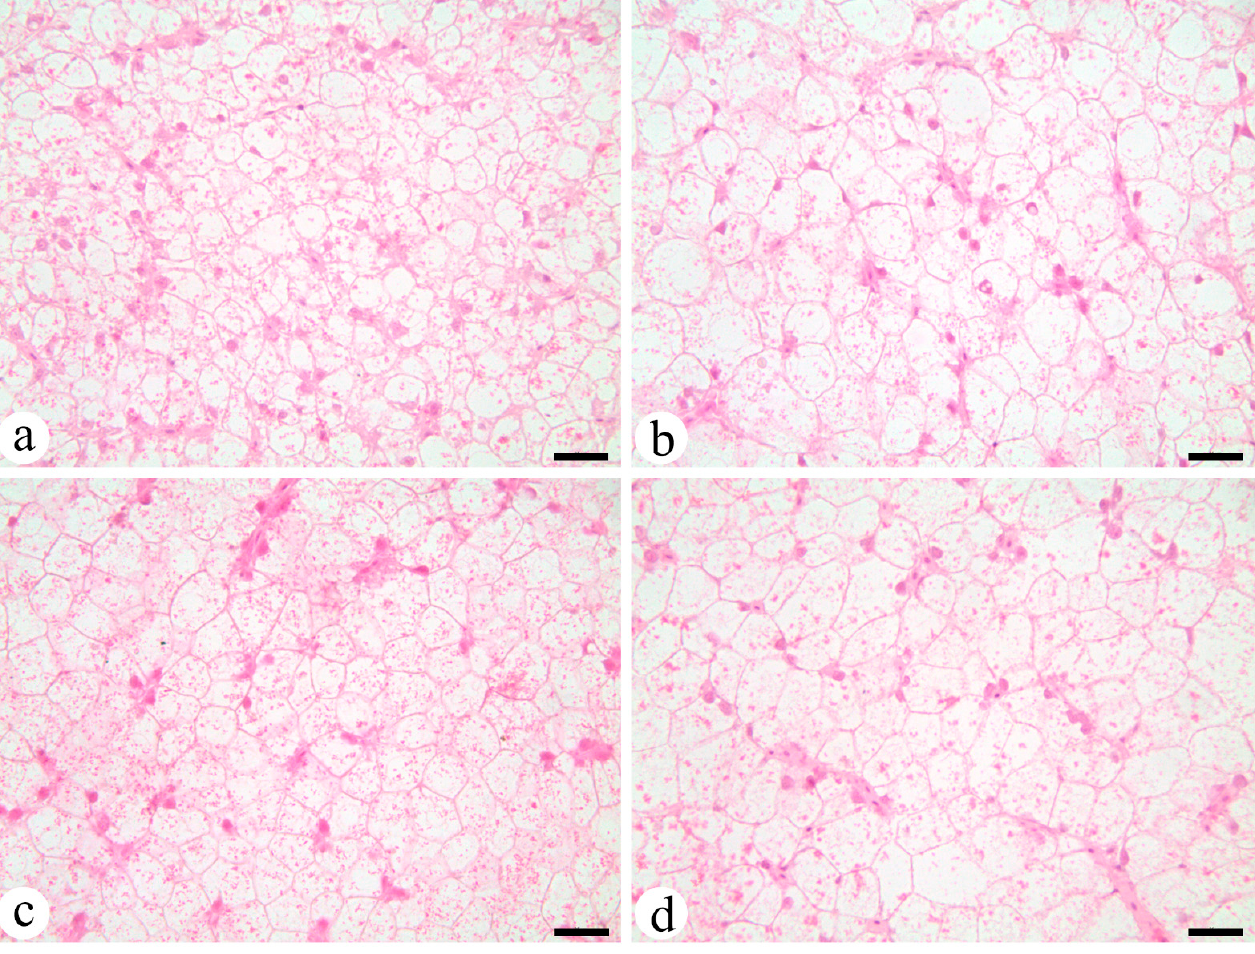
Figure 2. Morphologies of the hepatocytes of dusky grouper juveniles after the 8-week feeding trial. ( a ) PL1 group; ( b ) PL2 group; ( c ) TG1 group; ( d ) TG2 group. Bars 25 μ m.